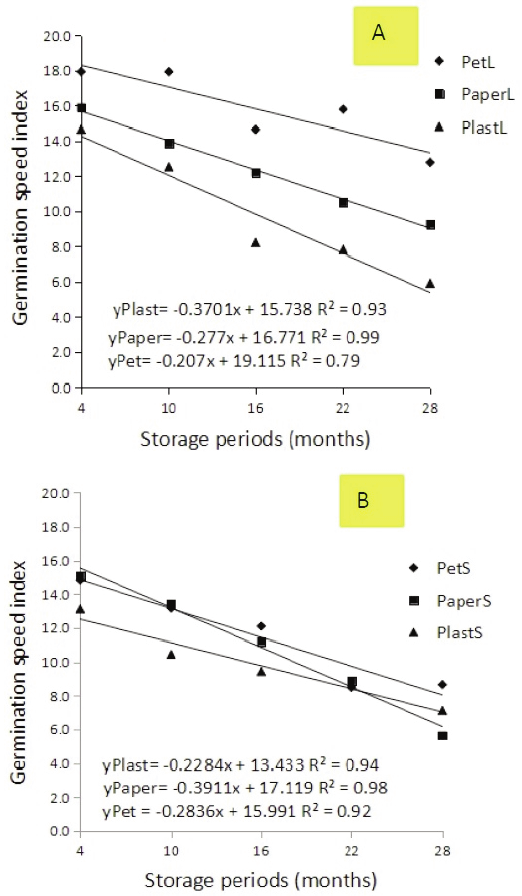
Fig. 2 - Mean values for the germination speed index of large (A) and small (B) seeds of Pochota fendleri submitted to dif- ferent packaging and months of storage. Pet L= Pet bot- tles, Large; Paper L= Paper bags, large; Plast L= transpa- rent plastic containers, Large; Pet S= Pet bottles, Small; Paper S= Paper bags, Small; Plast S= transparent plastic containers, Small. Table 2 - Summary of the variance analysis (Mean Squares and significance by the F test), coefficients of variation, and general means obtained for germination (G) germination speed index (GSI) and water content (U%) of Pochota fendleri for different packaging and storage periods